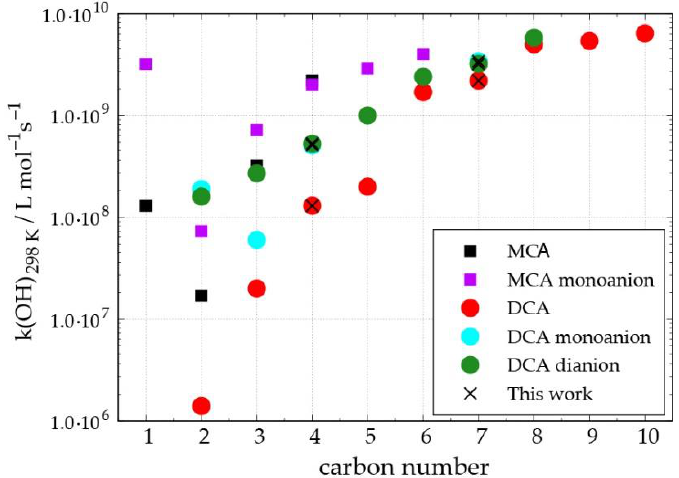
Figure 4. OH radical second order rate constants k 2nd as a function of the carbon chain length of the carboxylic acids (see more details in the Supplementary Materials). 264